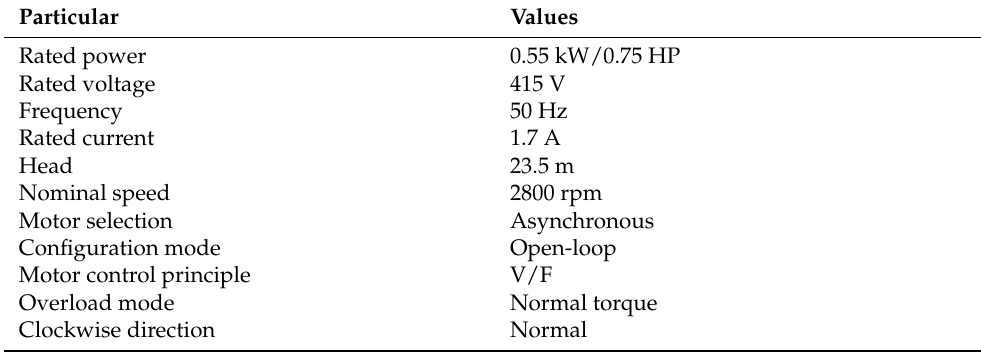
Table 3. Specification of experimental